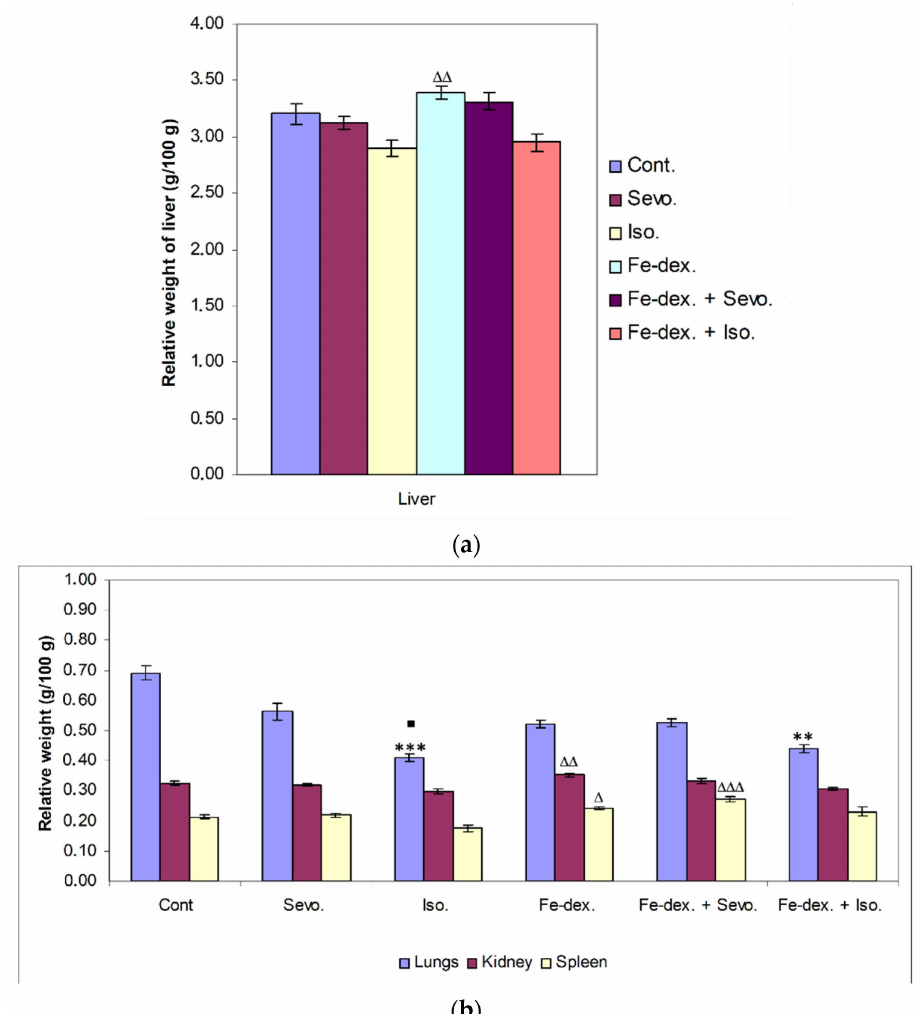
Figure 2. Relative weight of liver ( a ), lungs, kidney, and spleen ( b ) of rats treated with inhaled anesthetics, iron dextran, and their combination. Rats ( n = 10 per group) were treated with ip injection of iron dextran (50 mg/kg), exposed to 2.4 vol % sevoflurane inhalation and 1.3 vol % isoflurane inhalation, and exposed to a combination thereof where inhaled anesthetics were given 2 h after ip injection of iron dextran. Animals were treated every other day for 28 days. The results are expressed as the mean value of each experimental group ± SE. * Statistically significant compared to (cid:4) the control group (** p < 0.01; *** p < 0.001); Statistically significant compared to the sevoflurane (cid:4) p group ( < 0.05); ∆ Statistically significant compared to the isoflurane group ( ∆ p < 0.05; ∆∆ p < 0.01; and ∆∆∆ p < 0.001). Other statistically significant changes exist in: ( a ) liver—Fe-dex. vs. Fe-dex. + Iso. ( p < 0.05); ( b ) kidney—Fe-dex. vs. Fe-dex. + Iso. ( p < 0.05). Abbreviations: Cont., control group; Sevo., sevoflurane group; Iso., isoflurane group; Fe-dex., iron dextran group; Fe-dex. + Sevo., group treated with iron dextran and sevoflurane; and Fe-dex. + Iso., group treated with iron dextran and isoflurane. The increase in liver, spleen, and kidneys weight in the iron-dextran- and iron-dextran + sevoflurane-treated groups suggest that iron accumulation in these organs may induce tissue damage and inflammation with respect to iron toxicity, while a decrease in